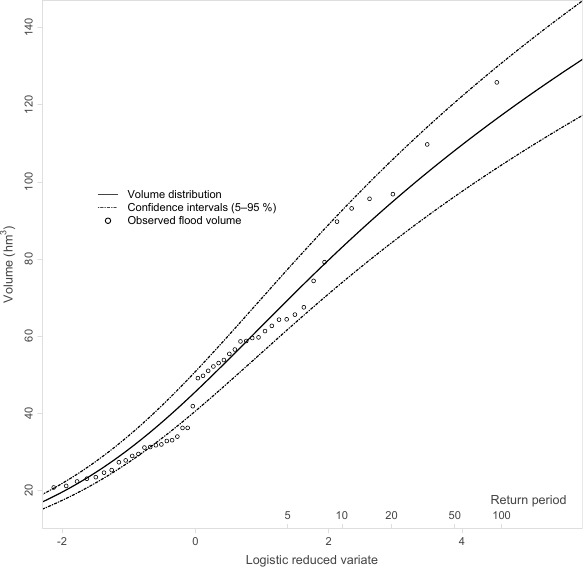
Figure 6. MWL frequency curves with 95% confidence limits for the single-site data and the multi-site data with the extra information